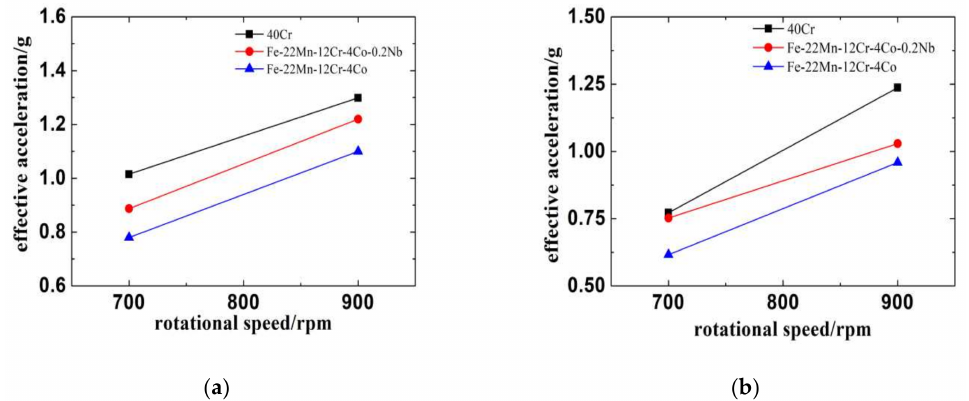
Figure 23. Comparison of test results at different speeds when loading was 10 N · m: ( a ) measuring point 4; ( b ) measuring point 6.